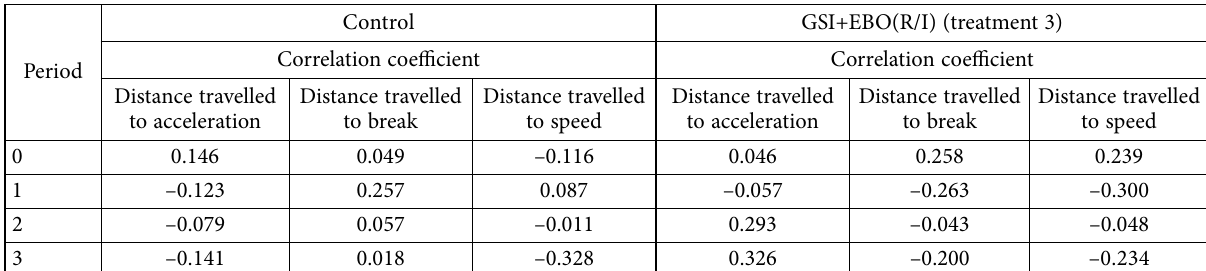
Table 8. Case Study 2, correlation of all drivers’